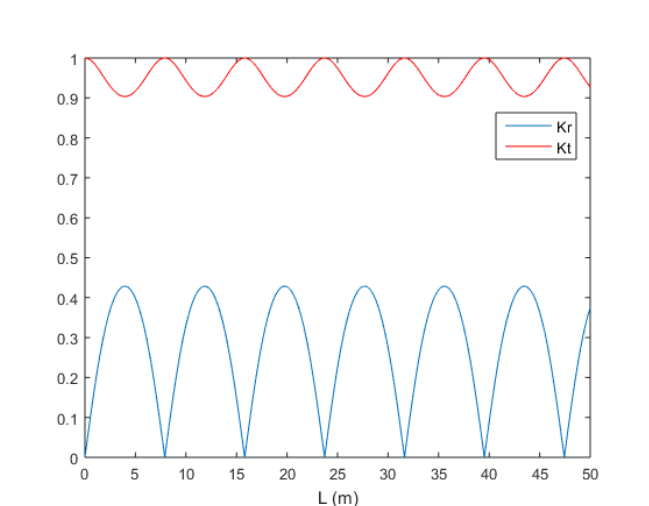
Figure 9. Analytical K t and K r for breakwater’s length in the range of 0 ≤ L ≤ 50 m. h 0 = 10 m and h 1 = 4 m.